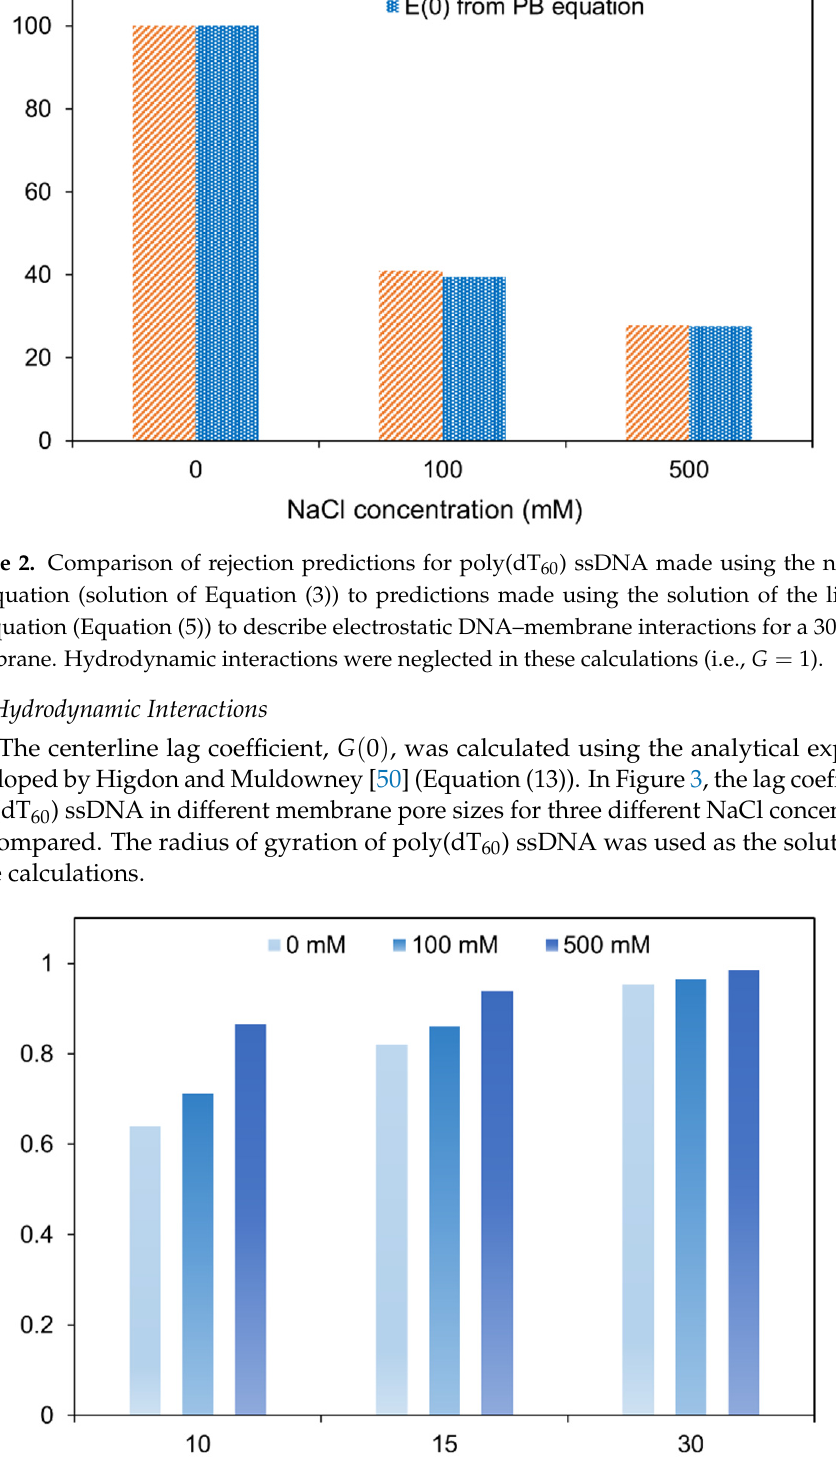
Figure 3. Model predictions for the centerline lag coefficient of poly(dT 60 ) ssDNA with effective size of R G in different membrane pore sizes at different NaCl concentrations.